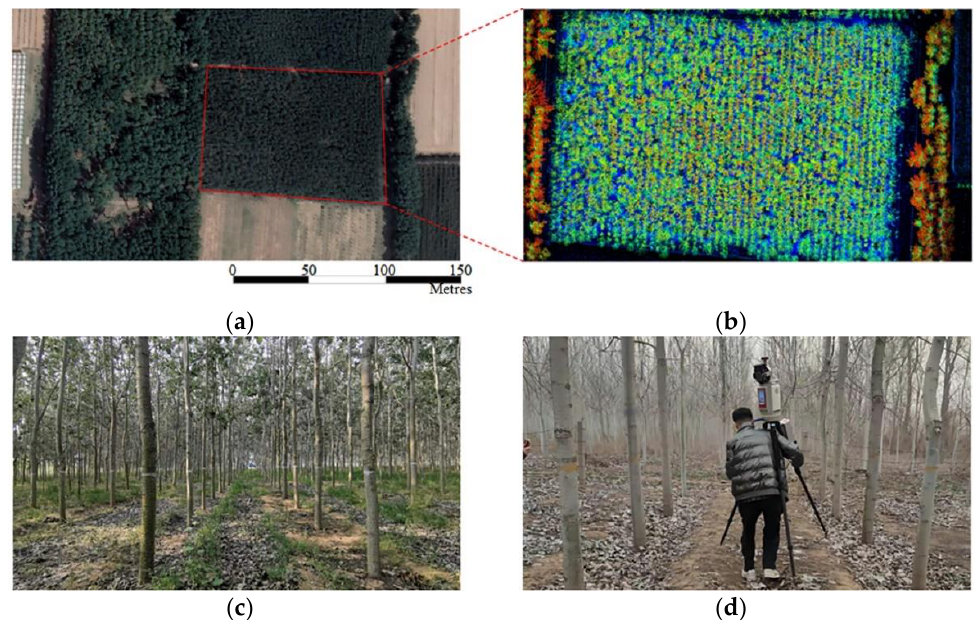
Figure 3. Condition of the Populus tometosa study area: ( a ) RGB aerial view of hairy poplar; ( b ) Aerial view of cloud map of hairy poplar sample site; ( c ) RGB image of hairy poplar sample site clearly illustrating the inter-plant spacing and inter-row relationship; ( d ) Our use of TLS to collect data.